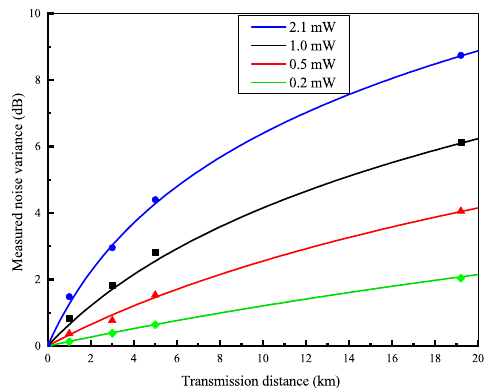
Figure 3. The dependence of the measured noise variance of a coherent state on the transmission distance in the fiber. The green, red, black, and blue traces correspond to the powers of LO beam in BHD2 of 0.2 mW, 0.5 mW, 1.0 mW and 2.1 mW,